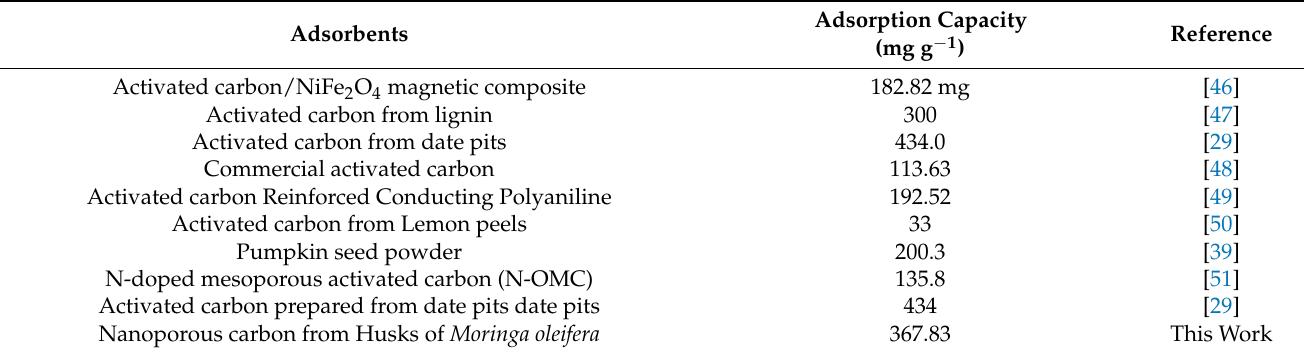
Table 7. Adsorption capacities (Q max ) of MeO dye on various adsorbents.